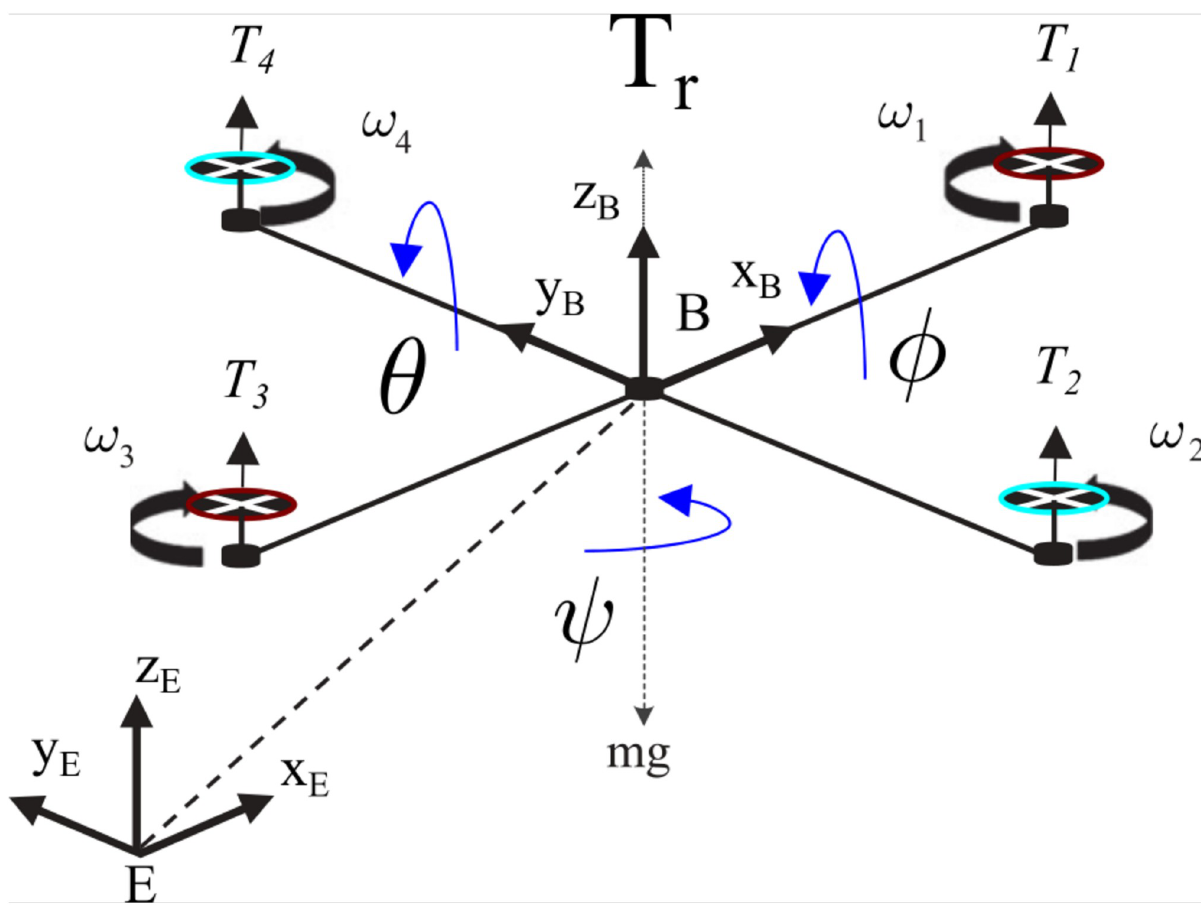
Fig 1. Quadrotor